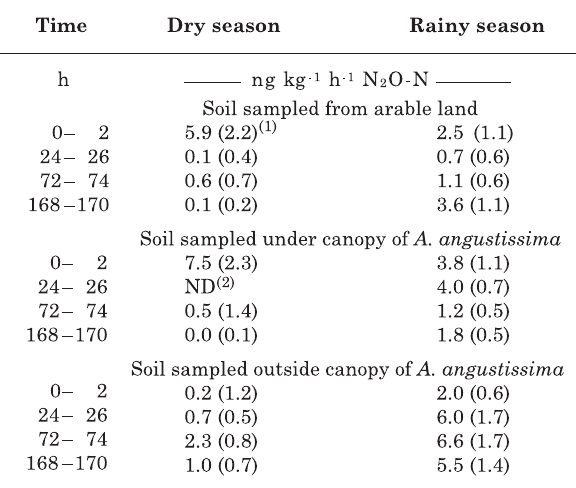
Table 2. N O emission from arable soil and 2